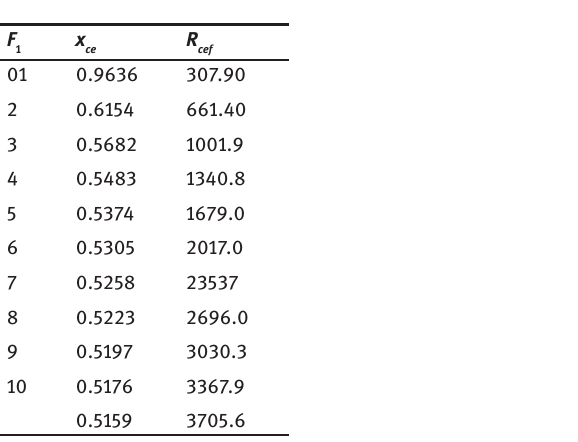
for D =0.02 , V = 1 1 a r